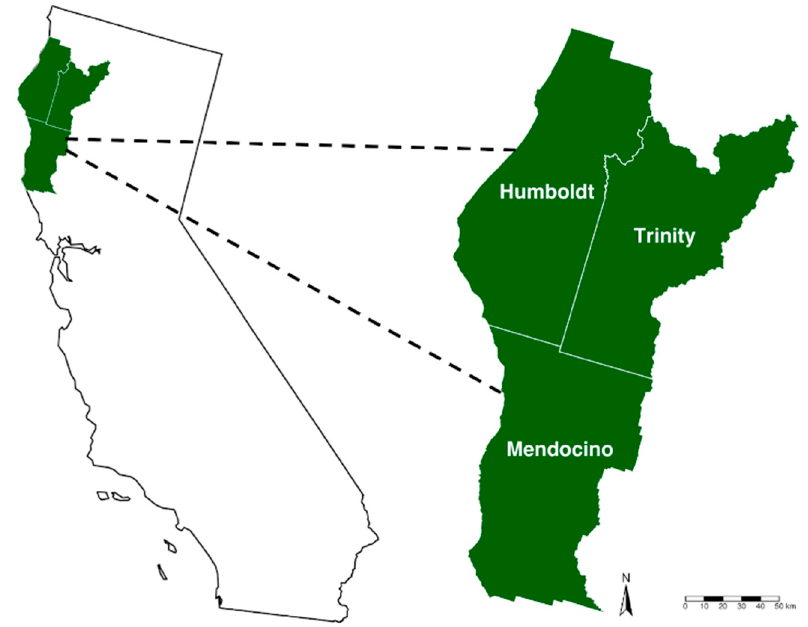
Figure 1. Map of the Emerald Triangle along the North Coast of California.